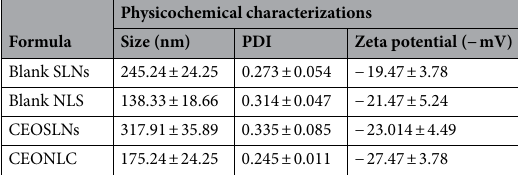
Table 2. Physicochemical properties of the prepared Coriander oil-lipid nanoparticles. Results are represented as mean ± SD for (n = 3).